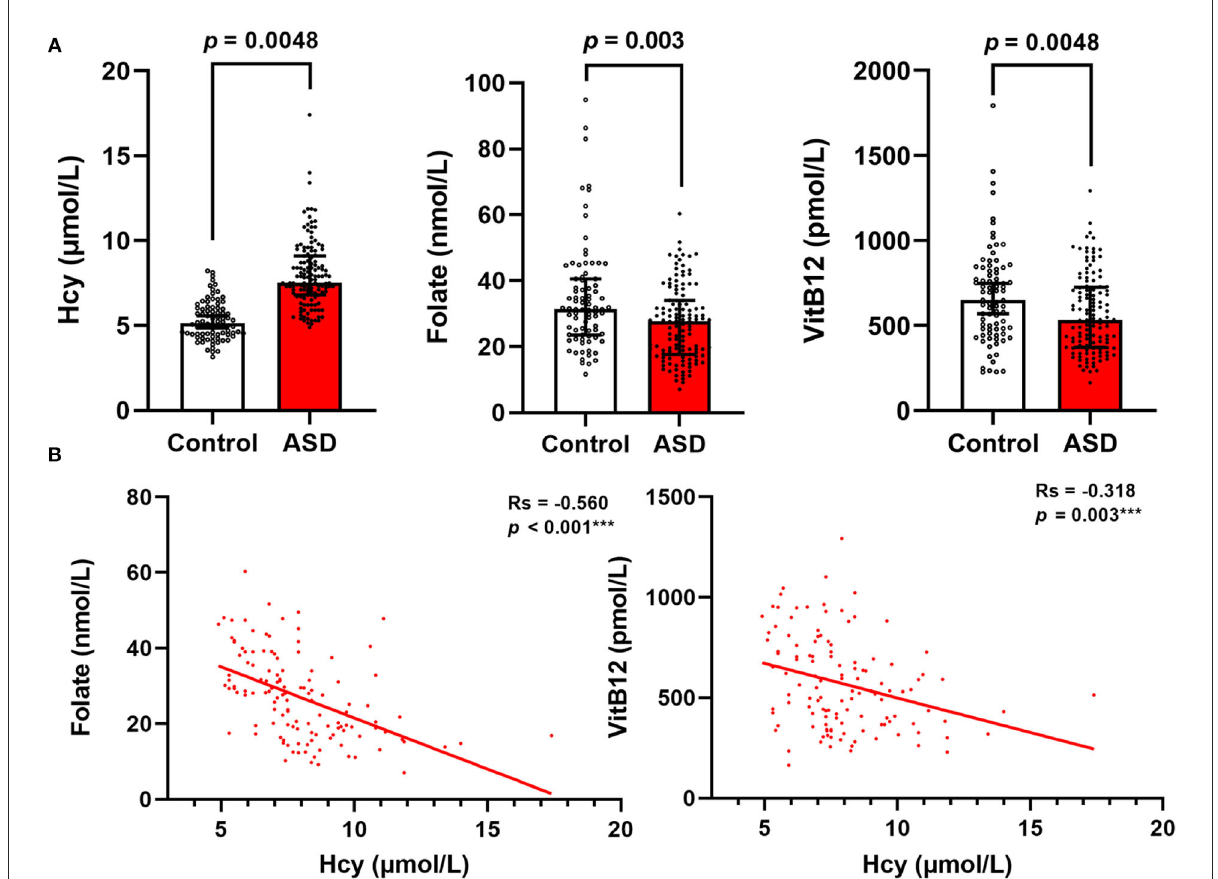
FIGURE1 Serum Hcy, folate, and VitB12 levels differ between children with ASD and healthy controls. (A) Comparison of Hcy, folate, and VitB12 levels between the two groups. (B) Correlations between serum Hcy, folate, and VitB12 levels in children with ASD. Results are presented as Spearman correlation coefficients ( r s ) and p-values. Hcy, homocysteine; VitB12, vitamin B12.